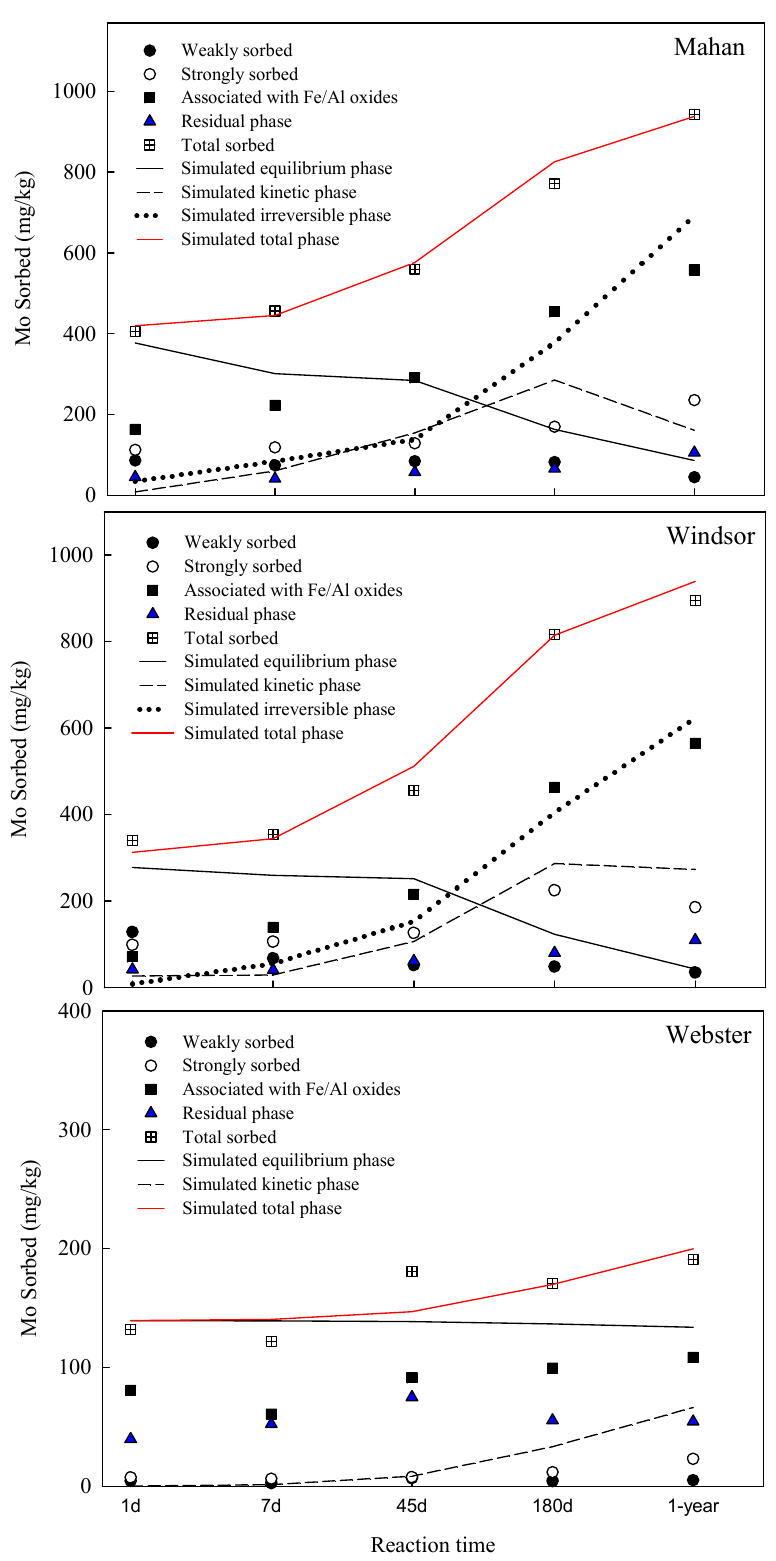
Figure 4. Total Molybdenum (Mo) sorbed by the different soils at the termination of adsorption. Data of different circles were from sequential extraction results. Dotted, solid, and dashed curves represent MRM simulation of total amount, equilibrium, and irreversible phase sorbed, respectively.